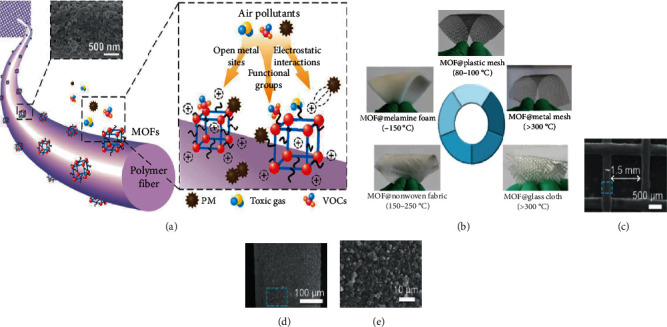
(a) Proposed capture mechanism of the MOF-based filter for air pollutants. Inset is the SEM image of the surface of the MOF/polymer composite fibre. (b) MOF filters based on various flexible substrates produced by a roll-to-roll hot-pressing method. (c–e) SEM images of the ZIF-8@plastic mesh achieved after seven layer-by-layer coating cycles. Reprinted with permission from Ref. [159] and Ref. [156]. Copyright 2016 and 2017, the American Chemical Society and WILEY-VCH.